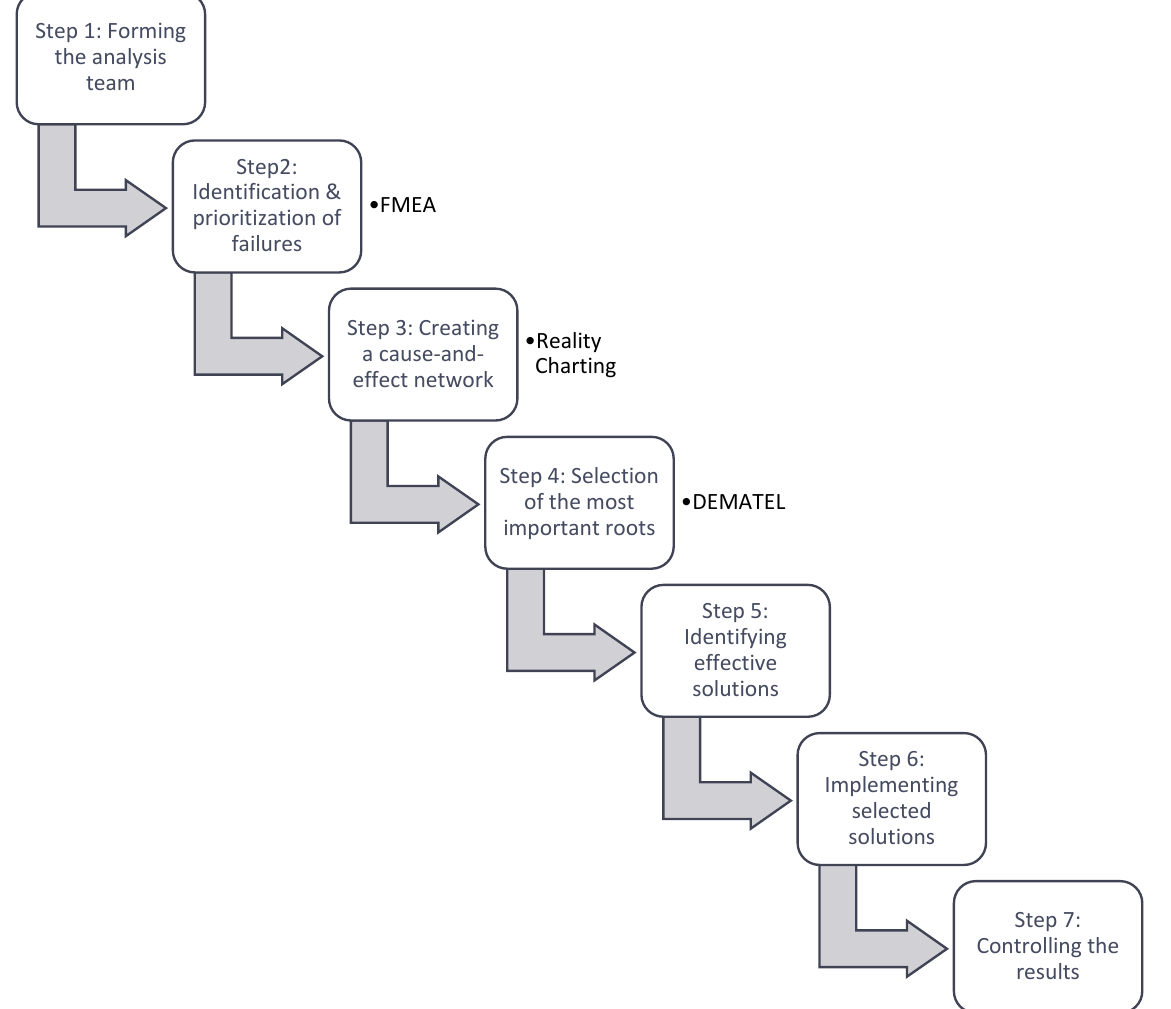
Fig. 1. The proposed process model for root cause failure